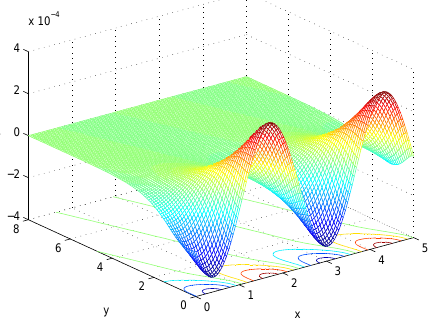
Fig. 8 Distribution the temperature component φ against both components of distance in the TPL model with